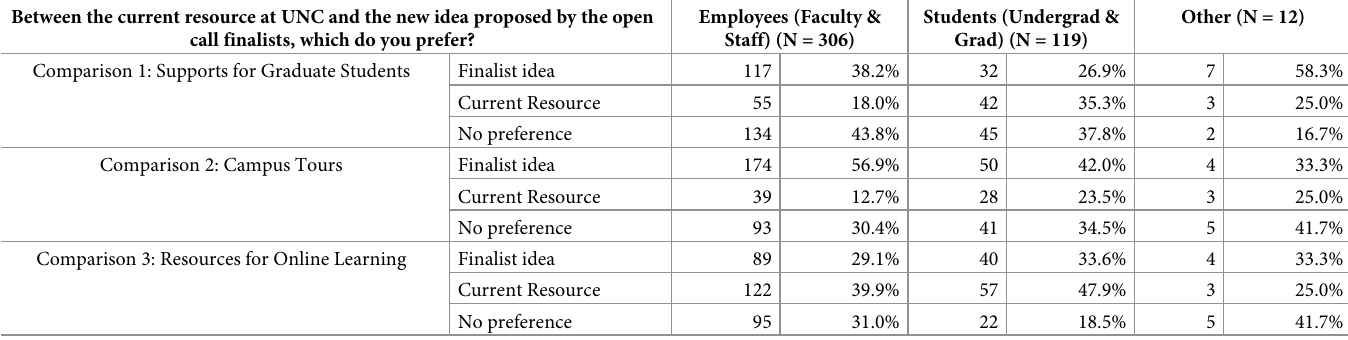
Table 4. Survey participants’ preferences for open call finalists’ COVID-19 safety strategies compared to currently existing resources at UNC, by university affiliation. Between the current resource at UNC and the new idea proposed by the open call finalists, which do you prefer?